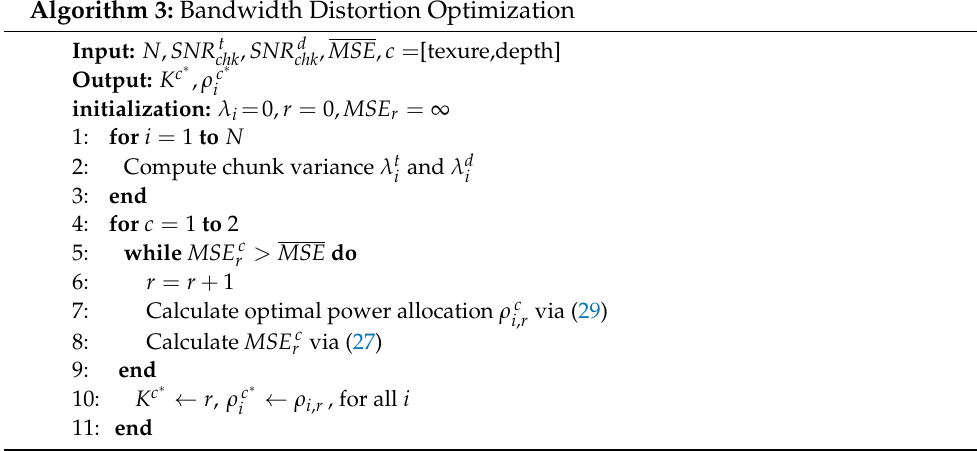
Algorithm 3: Bandwidth Distortion